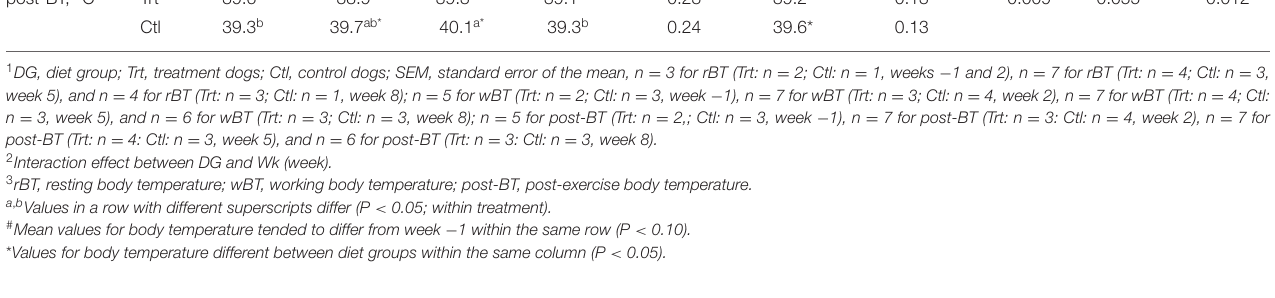
TABLE 4 | Mean respiratory rate (breaths per minute) at rest, work, and post-exercise during weeks − 1, 2, 5, and 8 for control (0.74% soluble fiber on a dry-matter basis) and treatment groups (2.12% soluble fiber on a dry-matter basis) in sled dogs running at a pace of 20km/h for 3km. Exercise challenge SEM (Wk) Mean a SEM (mean) P -value